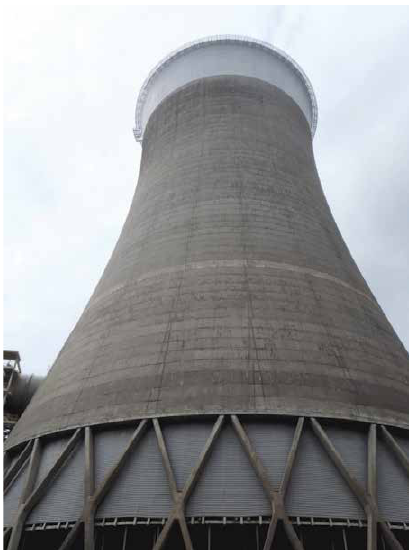
Figure 5. Cooling tower at Cardinal plant in eastern Ohio